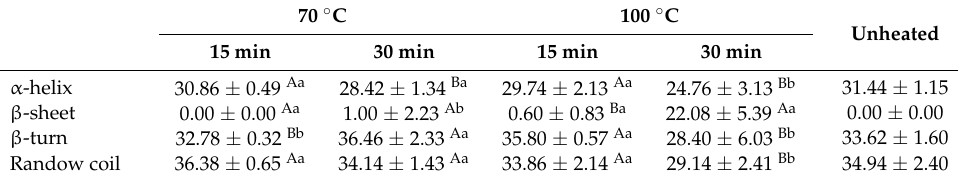
Table 2. Content of secondary structure units of myosin under different heating degrees (x ± s, n =